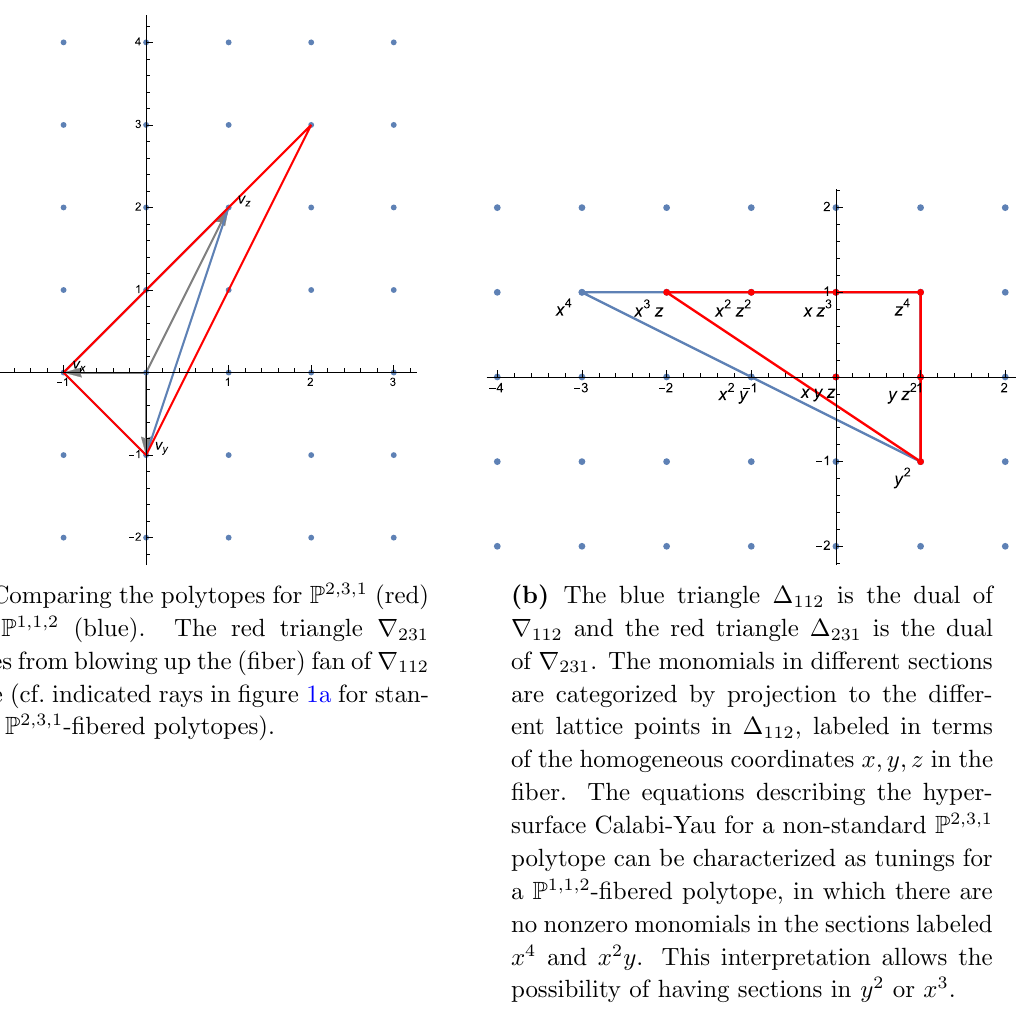
Figure 5. The re(cid:13)exive polytope pairs for the P 1 ; 1 ; 2 ambient toric (cid:12)ber (in blue) and the P 2 ; 3 ; 1 = Bl 2 P 1 ; 1 ; 2 ambient toric (cid:12)ber (in